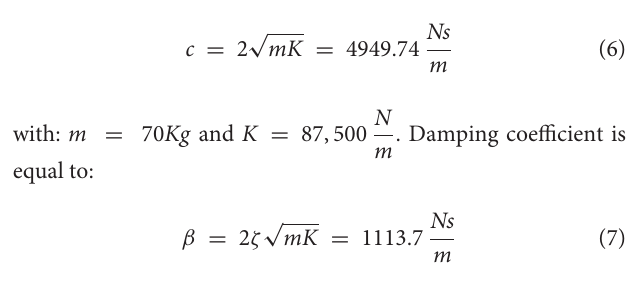
FIGURE 2 | Sketch of the working principle of the variable stiffness joint implemented in hip, knee, and ankle joints on the sagittal plane: (A) link1 is fixed (3 DoFs); (B) rotation is avoided (if link 1 is fixed) (2 DoFs); (C) two links are fixed and rotation is avoided (1 DoF).